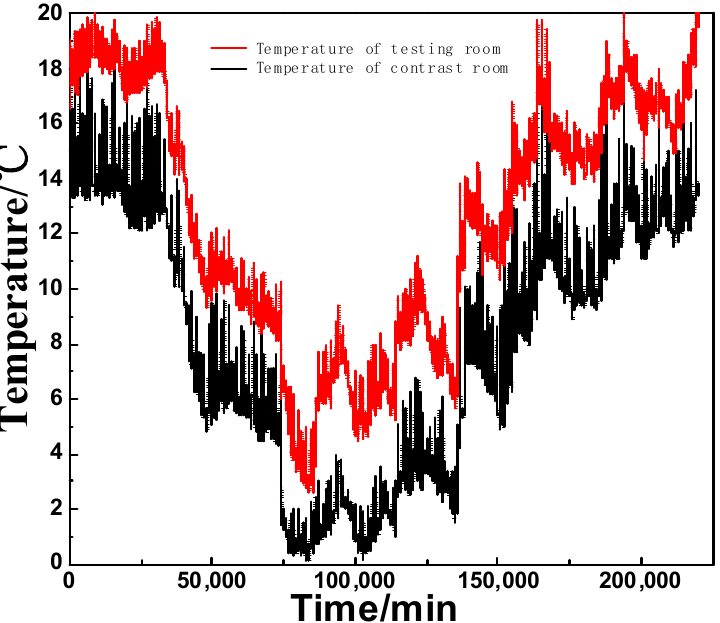
Figure 3. Recorded temperatures of testing rooms, contrast room and outdoor natural environment.